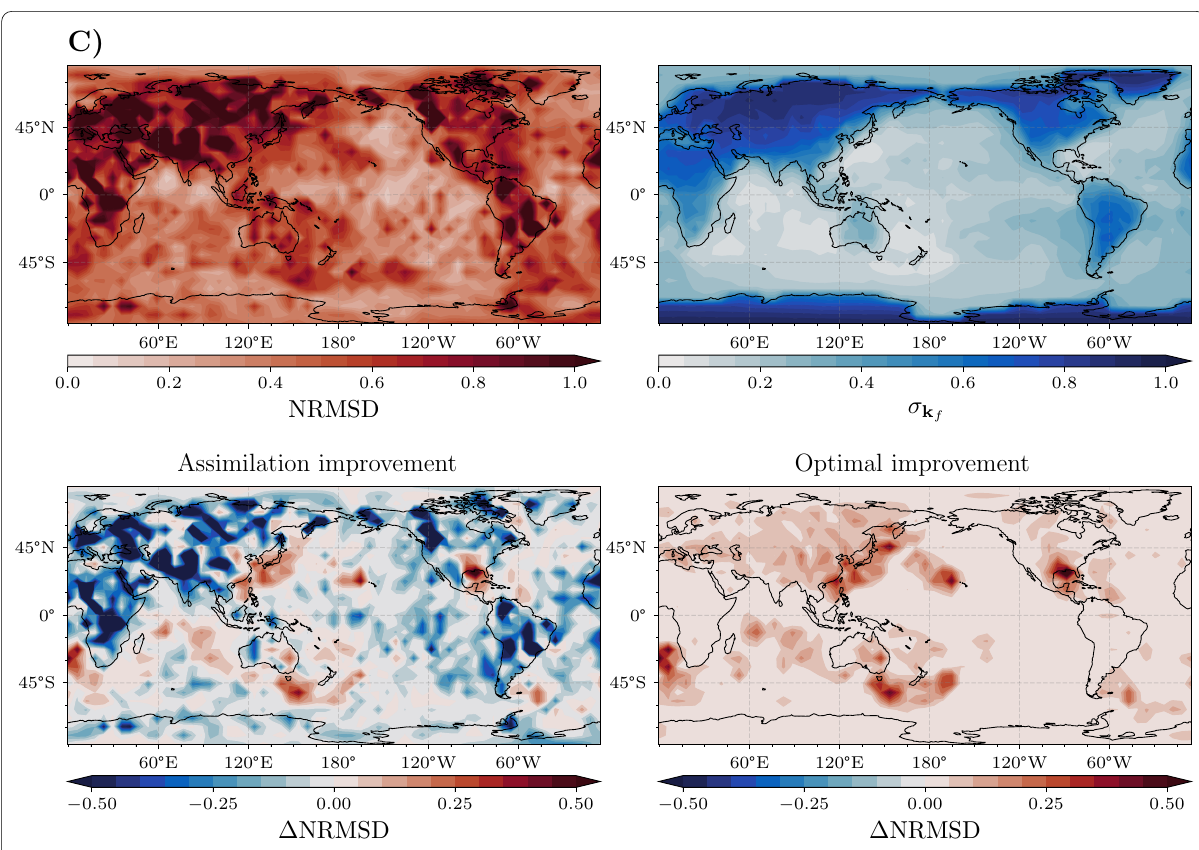
Fig. 13 The assimilation results using an imposed OIMF based on a different ocean conductivity. The top left plot shows the final NRMSD between the rescaled and true OIMF anomalies, and in the top right, the corresponding uncertainty of the determined scale factor is shown. In the bottom left, the assimilation improvement demonstrates how the imposed deviations are changed through assimilation (presented as the difference between imposed NRMSD and rescaled NRMSD). As a comparison, the bottom right plot shows the best possible improvement by an optimal